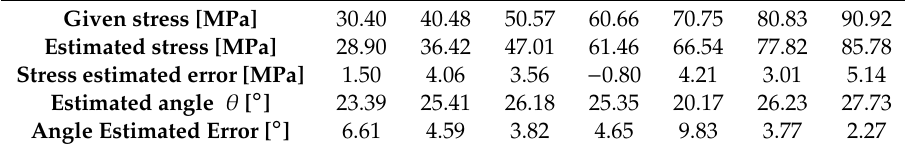
Figure 14. Stress estimation results ( a ) Hot-rolled specimen (SA.2) and ( b ) Extruded specimen (SB.2). Table 5. Estimated results and errors for the hot-rolled specimen (SA.2).